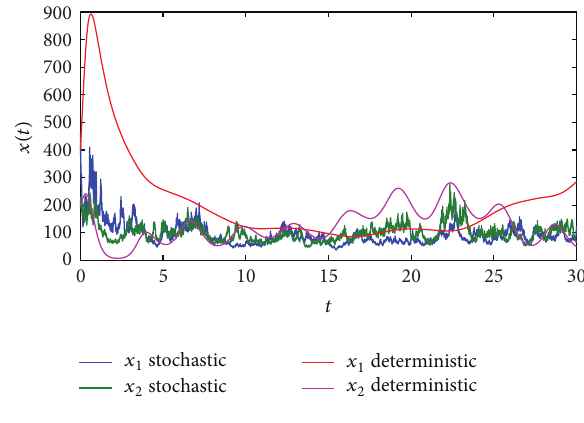
Figure 1: Solutions of (89) with parameters (90) and initial data